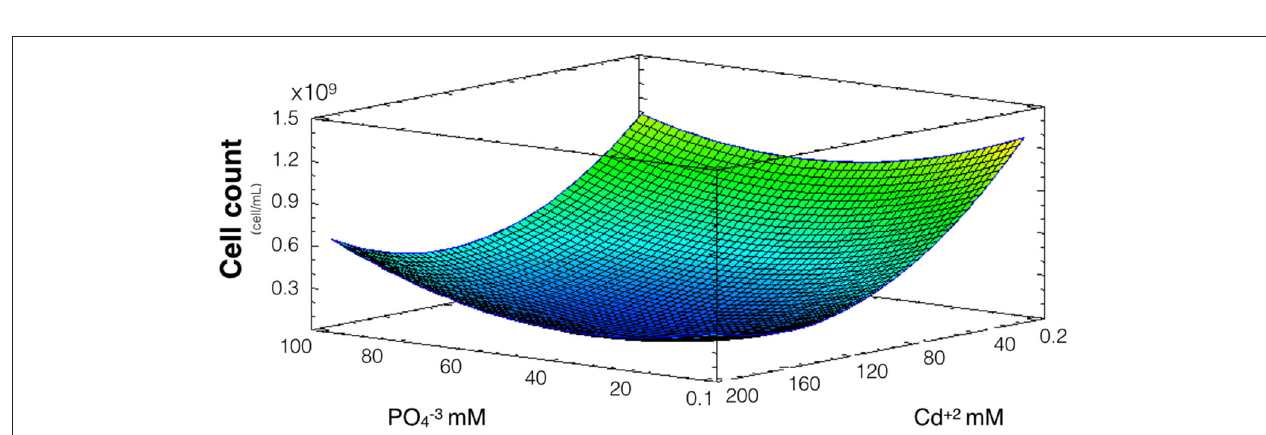
FIGURE 2 | Response surface for a two variables model describing the effect of cadmium and phosphate culture concentrations on the uptake of Cd by A. thiooxidans cells at pH 3.5 ( R 2 : 88%; p < 0.05). Higher concentrations of intracellular cadmium are represented in warmest colors, tending to red.